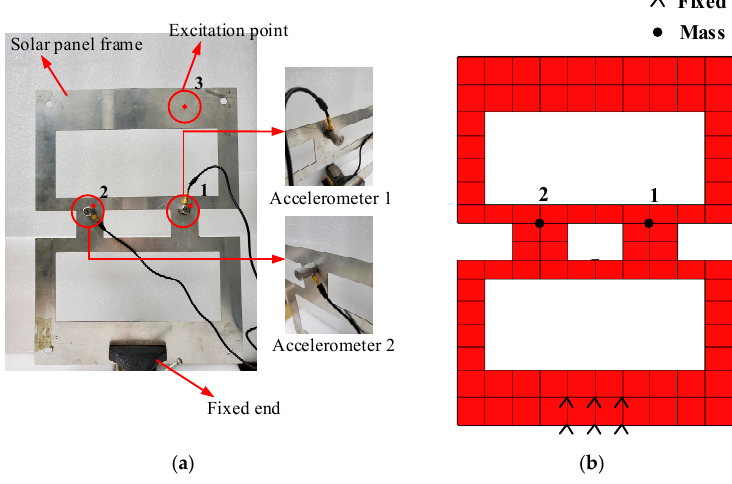
Figure 14. Accelerometers and excitation point: ( a ) Experimental arrangement; ( b ) FE model.